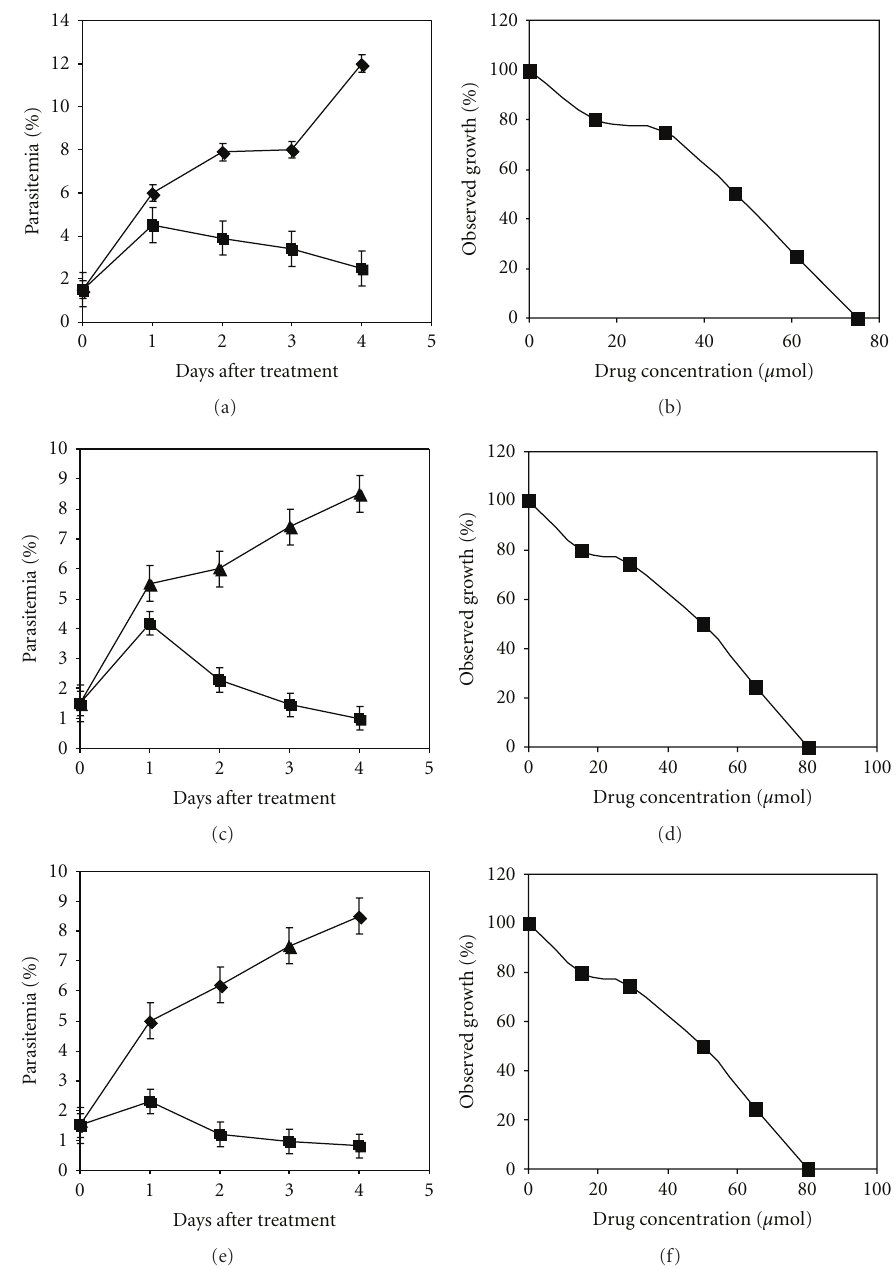
Figure 5: In vitro inhibition and dose-response curves of chloroquine-susceptible P. falciparum strain NF54. Parasitemias determined after inhibition with (a) 100 µ M 2,6-di- tert -butyl-phenol, (c) 100 µ M 2,4-di- tert -butyl-phenol, and (e) a combination of both compounds with 100 µ M each. Triangles indicate parasitemias of the untreated NF54 control while rectangles indicate the drug-treated strain. Each point represents the mean value of four di ff erent countings with ± standard deviations. Dose-response curves were obtained after inhibition with the compounds in the range of 10 µ M–100 µ M and IC 50 values were determined. (b) 2,6-di- tert -butyl-phenol, determined IC 50 = 50.29 µ M ± 3, and (d) 2,4-di- tert -butyl-phenol, determined IC 50 = 47.82 µ M ± 2,5, and (f) a combination of both compounds determined IC 50 = 42.5 µ M ±